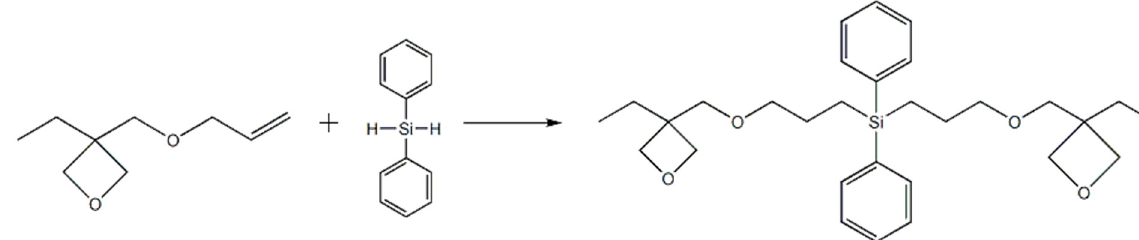
Figure 3. The synthetic route of bis[(3-ethyl-3-methoxyoxetane)propyl]diphenylsilane.